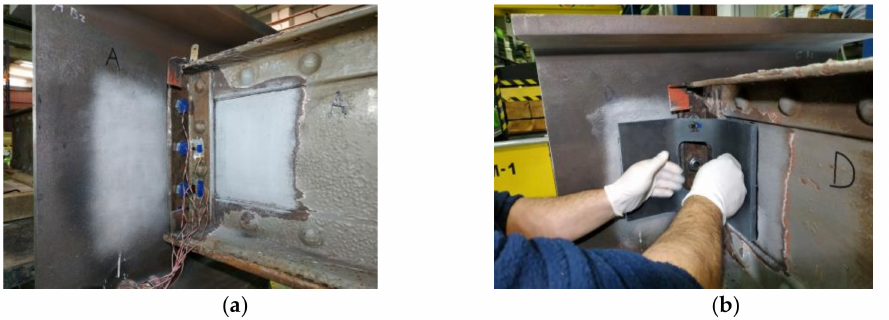
Figure 23. Installation of CFRP angles on the connection. ( a ) Metal surface preparation. ( b ) CFRP adhesive bonding.